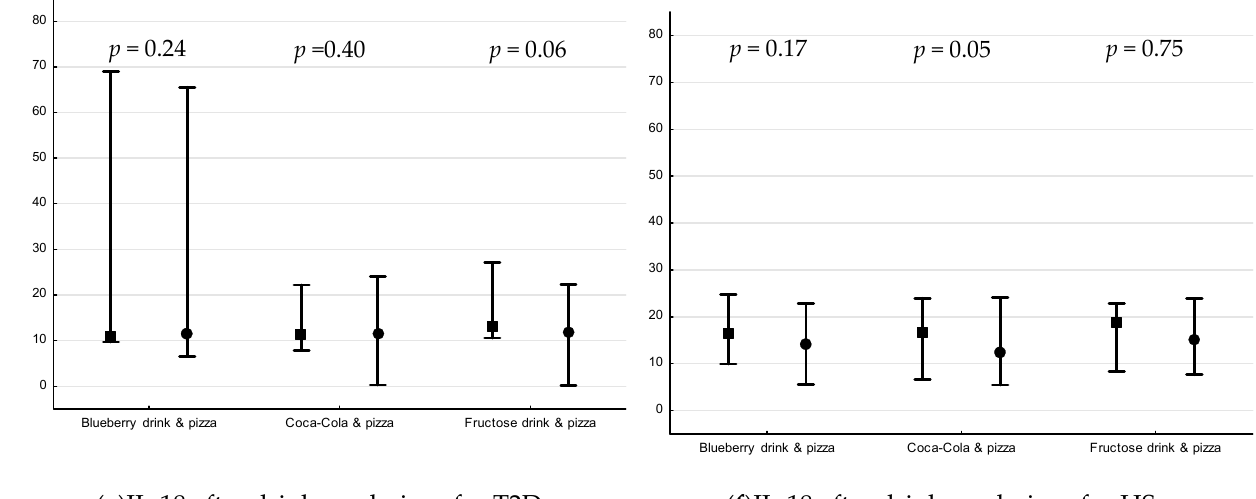
Figure 3. Plasma levels (median pg/mL [min, max]) of ICAM-1, VCAM-1 and IL-18 15 min before interventions and 240 min after drink + pizza interventions *. Baseline and endpoint levels of ICAM-1, VCAM-1 and IL-18, respectively. p -values for Wilcoxon matched pairs test. Square= − 15 min, circle = 240 min, respectively. ( a ) plasma ICAM-1 levels before and after drink + pizza intervention in T2D, ( b ) plasma ICAM-1 levels before and after drink + pizza interventions in HS, ( c ) plasma VCAM-1 levels before and after drink + pizza in T2D, ( d ) plasma VCAM-1 levels before and after drink + pizza in HS, ( e ) plasma IL-18 levels before and after drink + pizza interventions in T2D, and ( f ) plasma VCAM-1 levels before and after drink + pizza in HS.